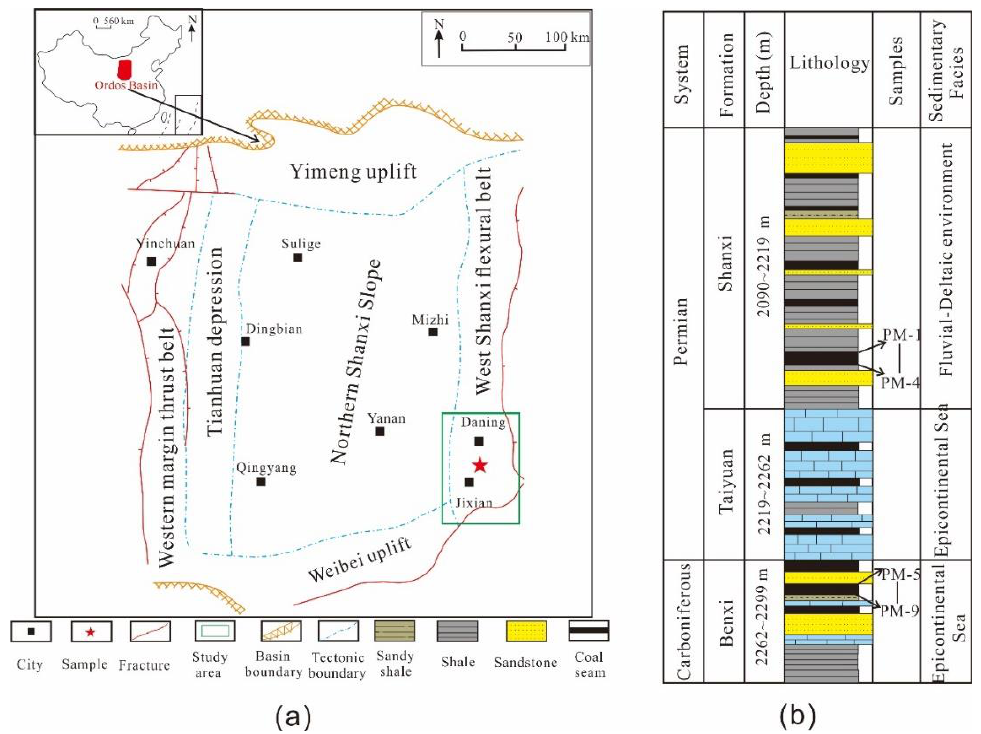
Figure 1. ( a ) Location of the study area. ( b ) Stratigraphic columns of the coal-bearing strata .